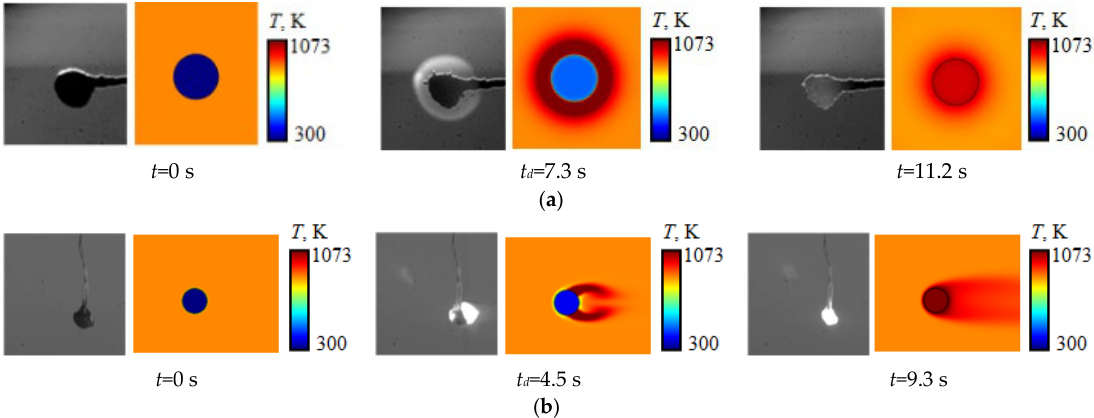
Figure 11. Temperature fields and videoframes obtained in experiments of ignition and combustion of CLF droplets No. 5 (FC 90% + cardboard 10%) at T g = 873 K [23] under the following conditions: ( a ) radiant heating ( V g ≈ 0); ( b ) convective heating ( V g ≈ 3 m/s).